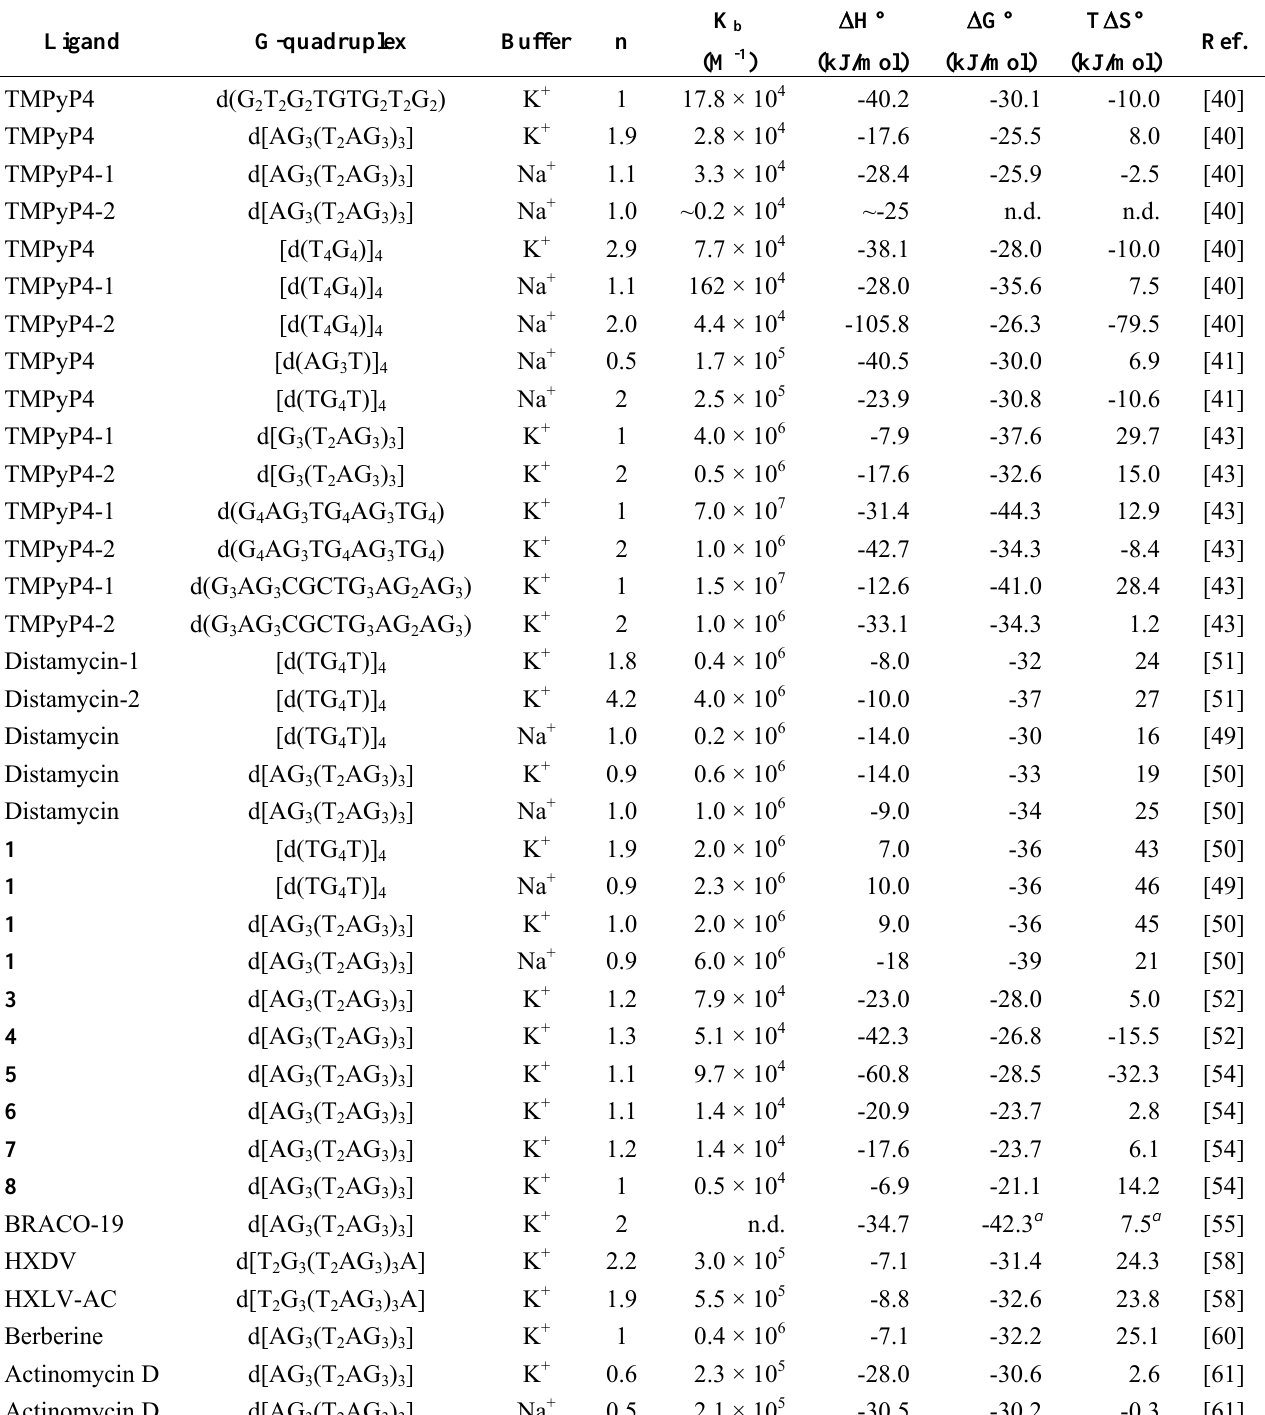
Table 1. Thermodynamic parameters for ligands binding to G-quadruplex structures obtained by ITC at 25